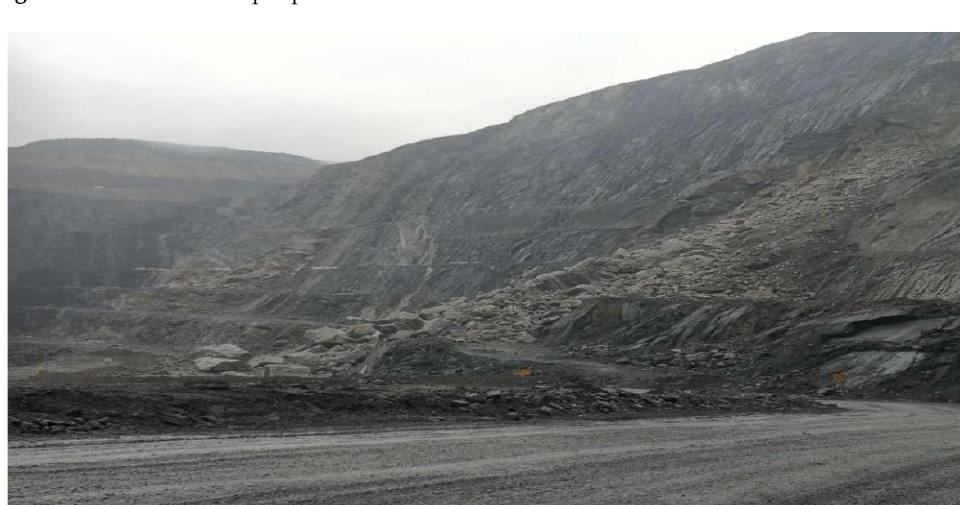
Figure 15. Landslide collapse process.